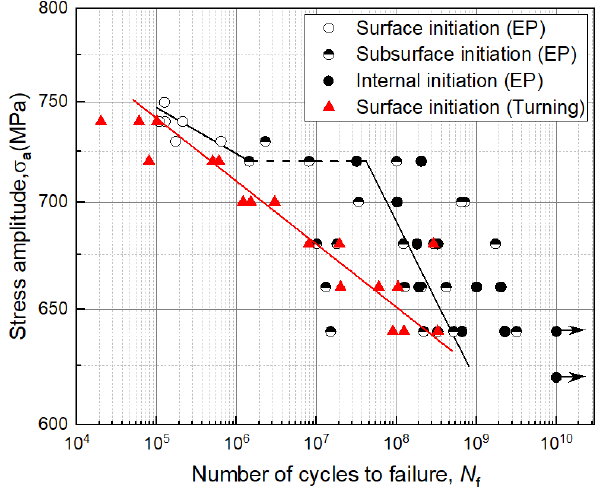
Figure 6. S-N plot for the fatigue test data of electropolished (EP) and turned samples for the studied TC11